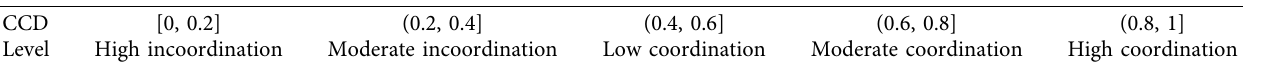
Table 5: Classification standard for system